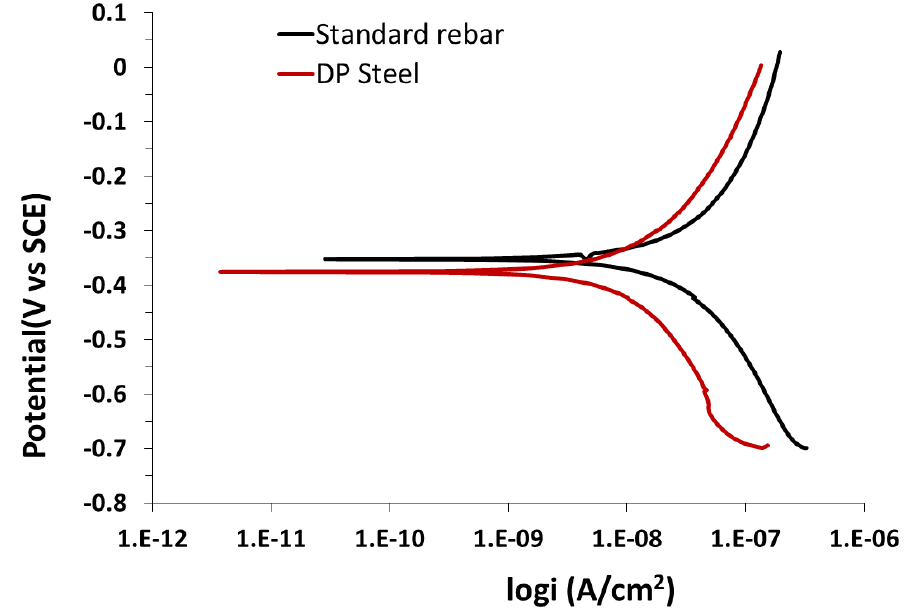
Figure 3. Potentiodynamic polarization results for standard rebar and DP steel in 0.9 M NaOH (pH = 13.9) + 0.2% Cl − solution.